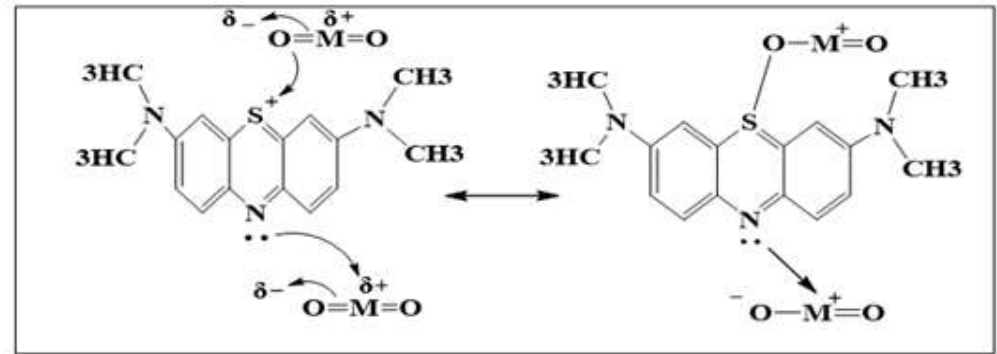
Figure (10): The suggested mechanism to remove methylene blue (MB) by